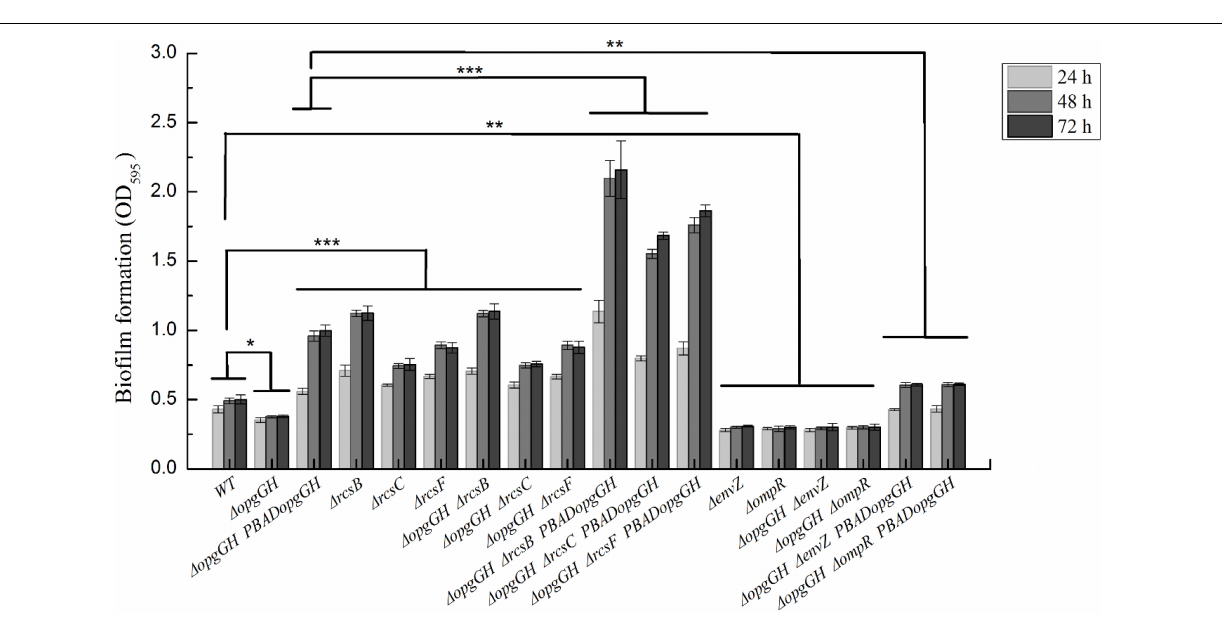
FIGURE 4 | Biofilm formation in wild-type and mutant strains of Y. enterocolitica . Bacteria were cultured in LNNS medium supplemented with 0.6 g/L L -arabinose at 26 ◦ C. Biofilm formation was analyzed after 24, 48, and 72 h of incubation by staining with crystal violet and measuring absorbance at 595 nm. The data are presented as the mean ± SD of at least three independent experiments. An asterisk indicates a significant difference with *** P < 0.001, ** P < 0.01, * P <